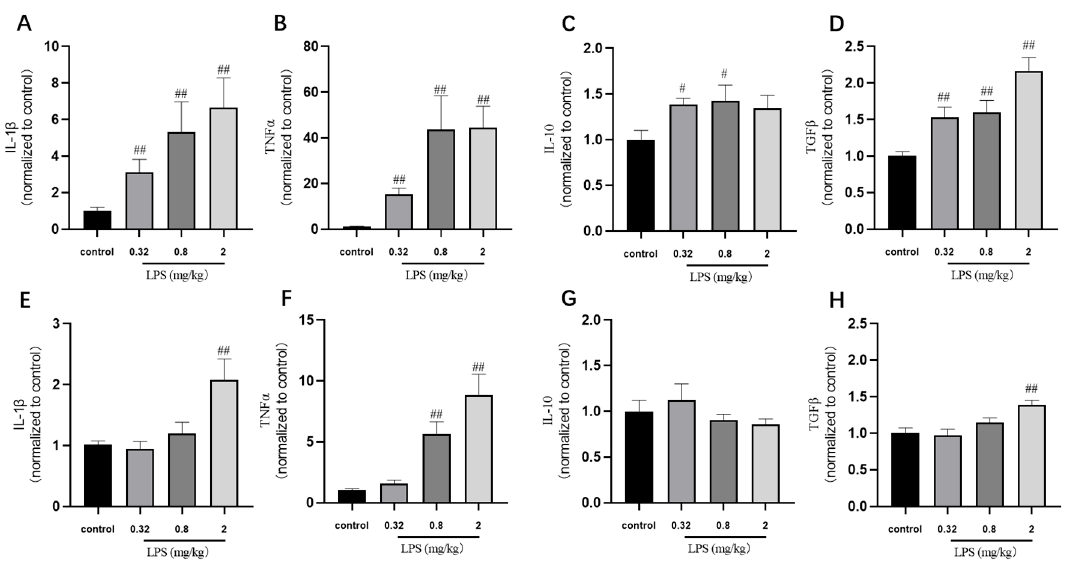
KYN pathway. The status of microglia in the hippocampus (Figure 5A,C) and the prefrontal cortex